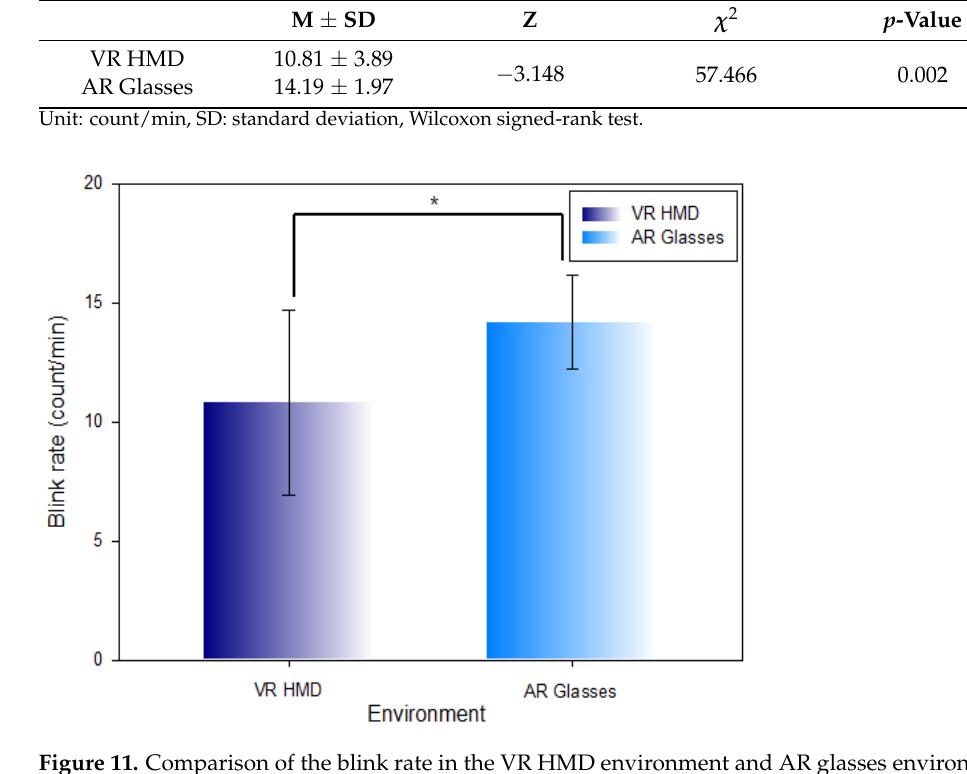
Figure 11. Comparison of the blink rate in the VR HMD environment and AR glasses environment (*: p < 0.05).